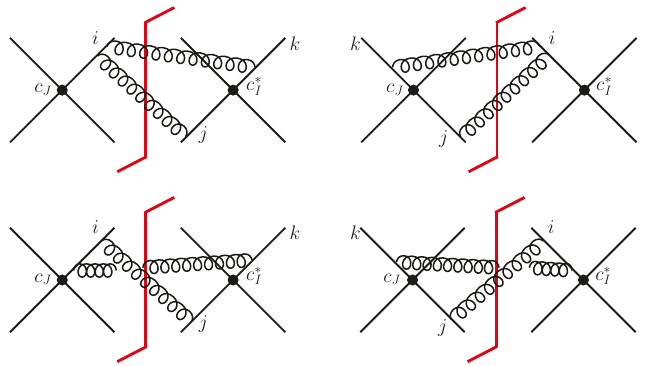
Figure 3 . A set of three-Wilson-line double-real diagrams adding up to a convolution of two NLO integrals.